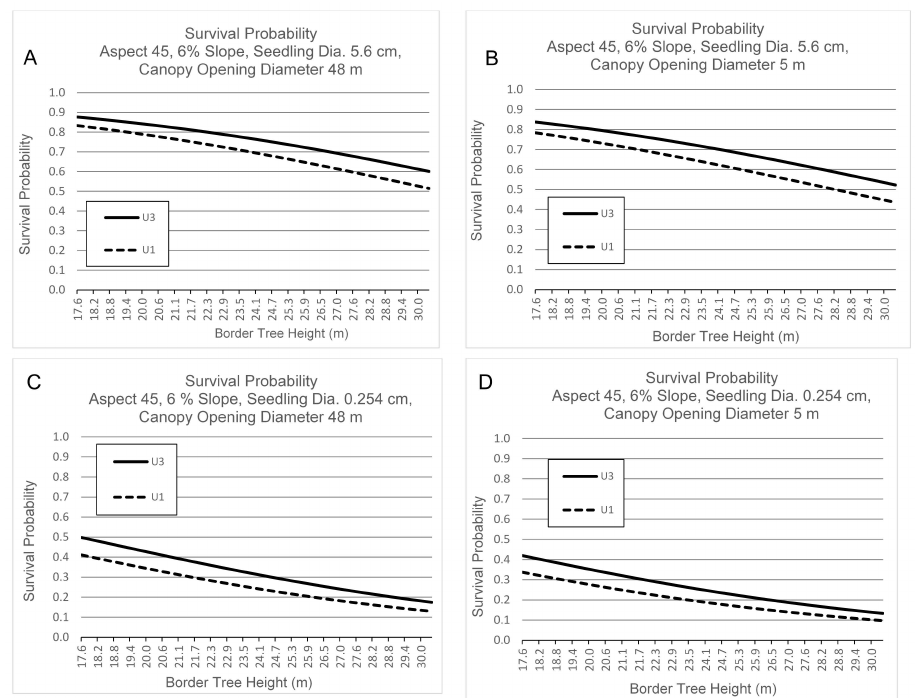
Figure 5. The relationship between canopy border tree height, survival probability and understory treatment (U3 is understory treatment with an herbicide applied to cut stems, U1 refers to no understory treatment). ( A )–( D ) With aspect of 45 degrees and 6% slope. ( A ) Seedling diameter = 5.6 cm, canopy diameter = 48 m. ( B ) Seedling diameter = 5.6 cm, canopy diameter = 5 m. ( C ) Seedling diameter = 0.254 cm, canopy opening diameter = 48 m. ( D ) Seedling diameter = 0.254 cm, canopy opening diameter = 5